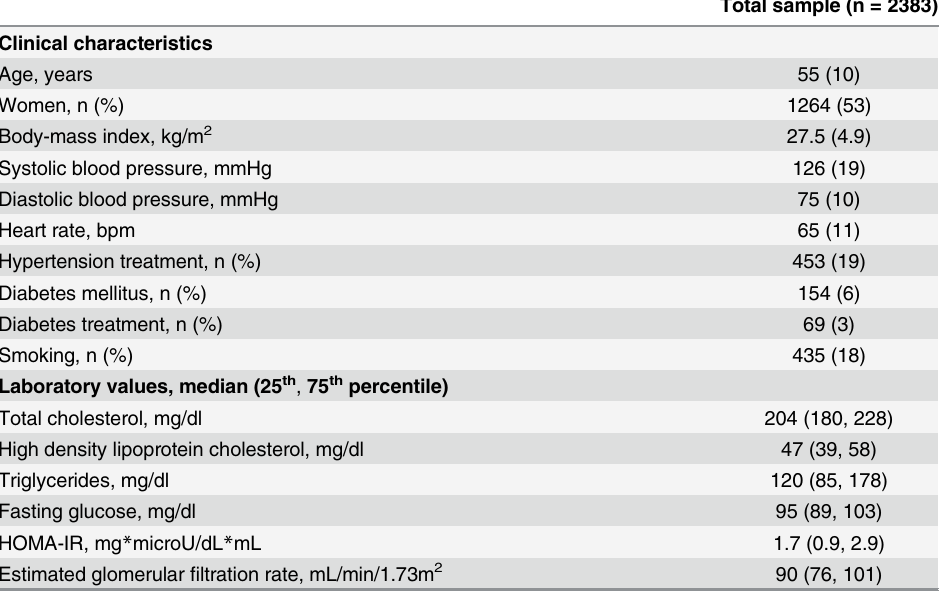
Table 1. Baseline characteristics of